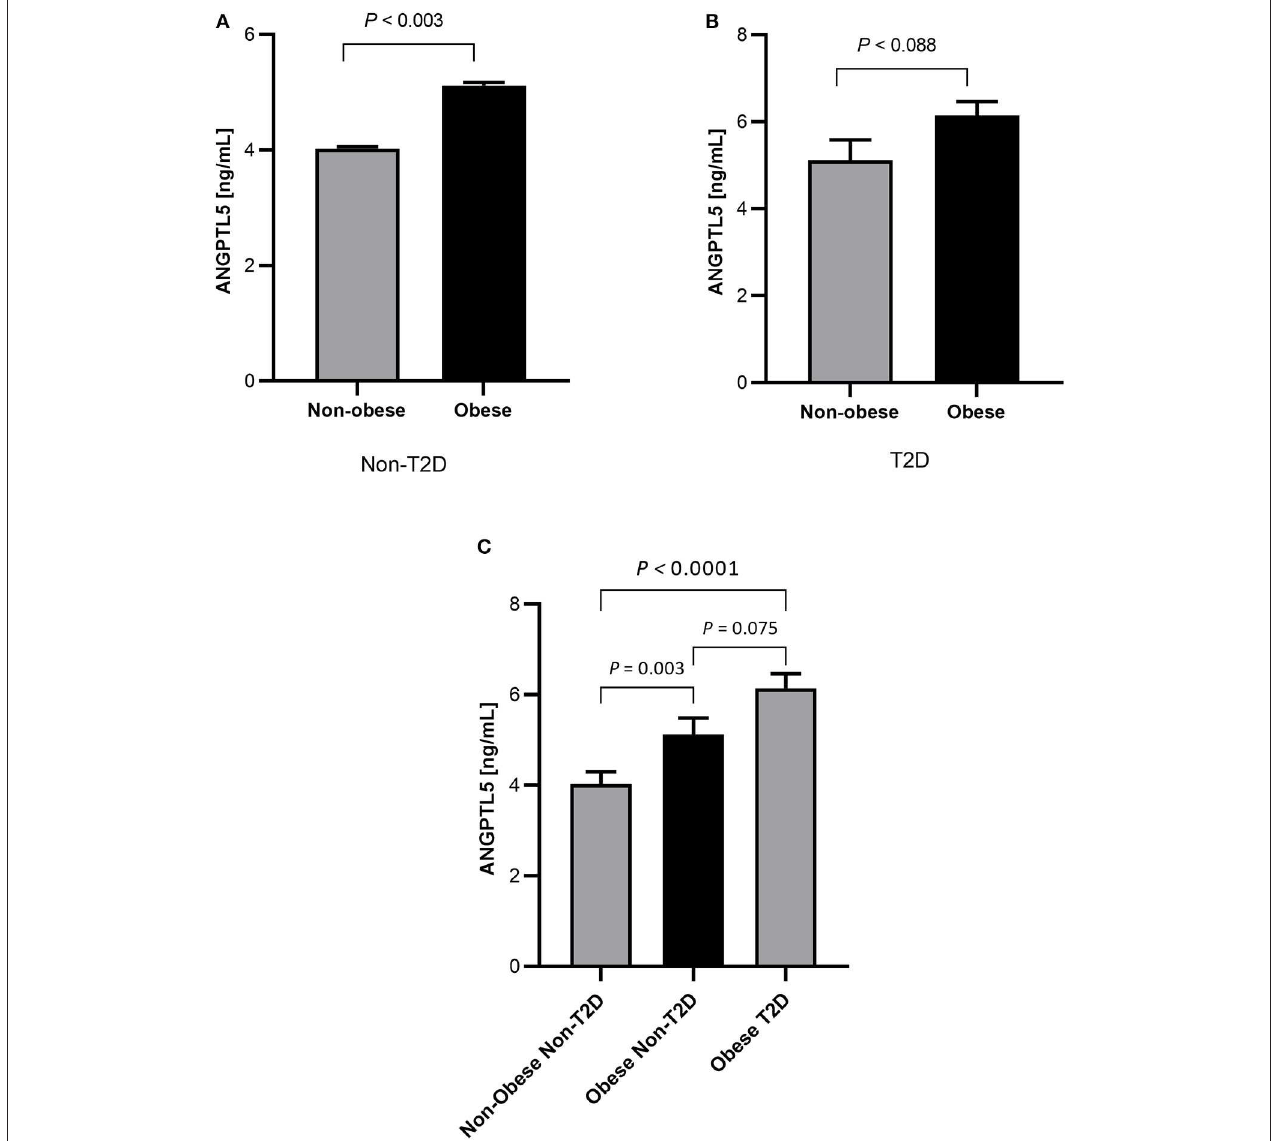
FIGURE 2 | (A) Circulation levels of ANGPTL5 in non-obese ( n = 70) vs. obese subjects ( n = 39) as measured by ELISA in non-diabetic people. (B) Circulation levels of ANGPTL5 in non-obese ( n = 34) vs. obese subjects ( n = 61) as measured by ELISA in people with T2D. P < 0.05 was considered significant as determined using student’s t -test. (C) Circulation levels of ANGPTL5 in non-obese non-T2D ( n = 70), obese non-T2D ( n = 39), and obese T2D ( n = 61) as measured by ELISA. P < 0.05 was considered significant as determined using one-way